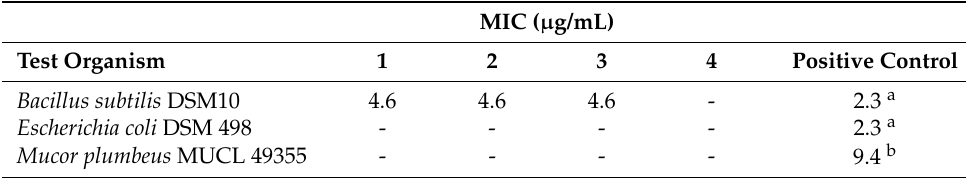
Table 2. Antimicrobial activities of compounds 1 –